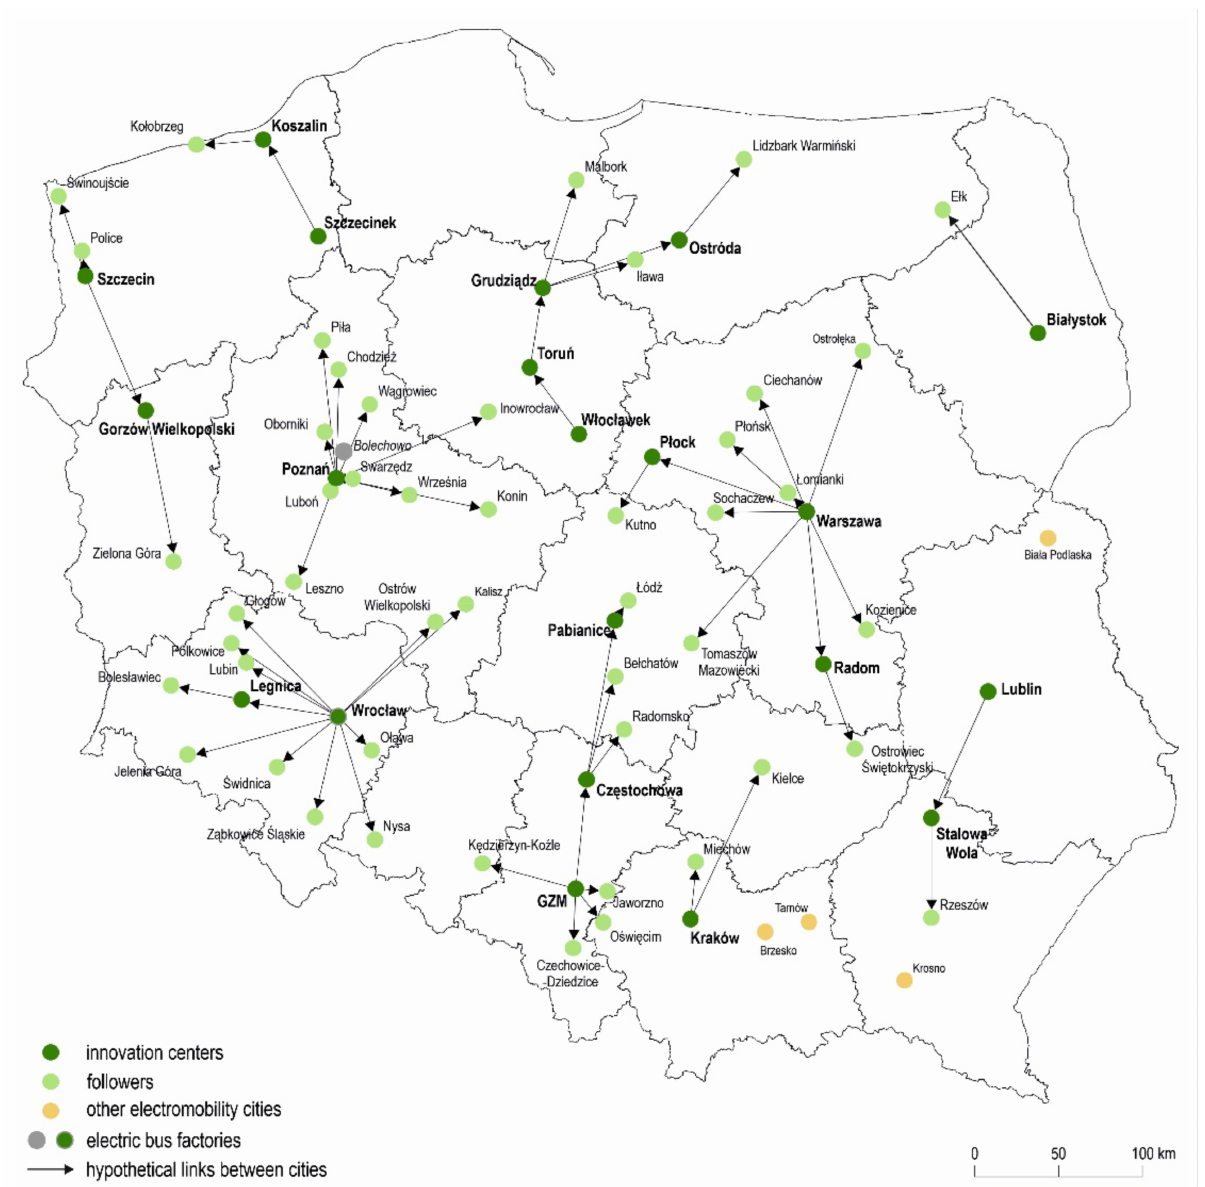
Figure 5. Hypothetical links between electromobility